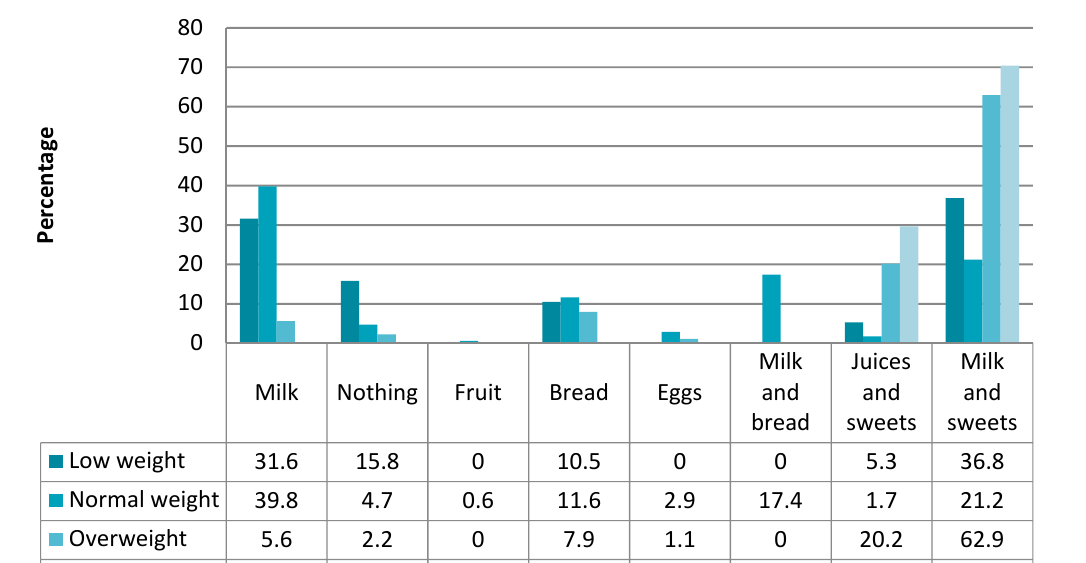
Figure 5. Food consumption at breakfast according to BMI after the intervention. Another significant change ( p < 0.001) was observed in the eating habits during the mid-morning break in the children who ate sugary snacks , either with or without dairy products, as they reduced their consumption of such foods and began eating mainly fruit and sandwiches. Focusing on sandwiches as mid-morning snacks, an increase of 7.1% was observed. Food consumption during the mid-morning break was also associated with BMI values ( p < 0.001), where children with low weight ate the most dairy products (26.3%) and fruit (15.8%) and ate sandwiches the least (42.1%), compared to 64.4% in those with normal BMI values and 78.7% in those overweight.